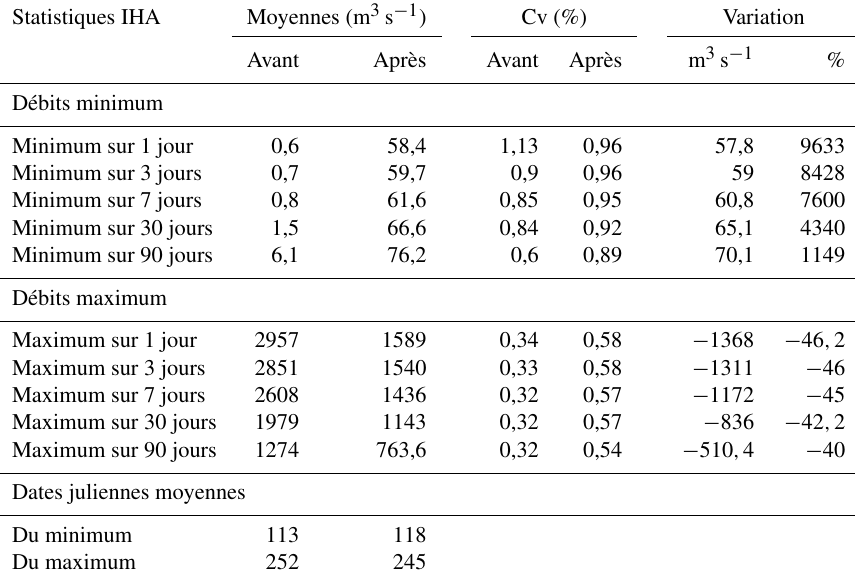
Tableau 3. Statistiques des débits maxima et minima de la Bénoué avant et après le barrage.